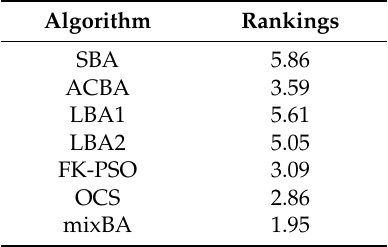
Table 5. Friedman test for the seven algorithms. SBA—standard bat algorithm; ACBA—bat algorithm with arithmetic centroid strategy; LBA—bat algorithm with L é vy distribution; PSO—particle swarm optimization; OCS—oriented cuckoo